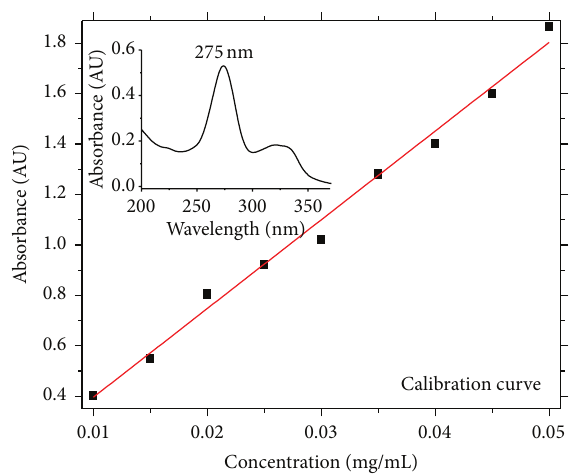
Figure 1: Absorbance intensity as a function of ciprofloxacin concentration in solution.